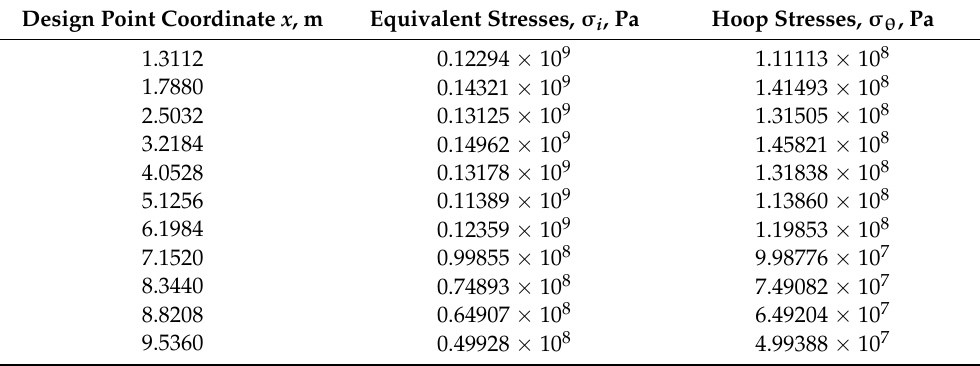
Table 3. The results of comparing the calculated values of the equivalent, σ i , and hoop, σ θ , stresses in the tank wall.